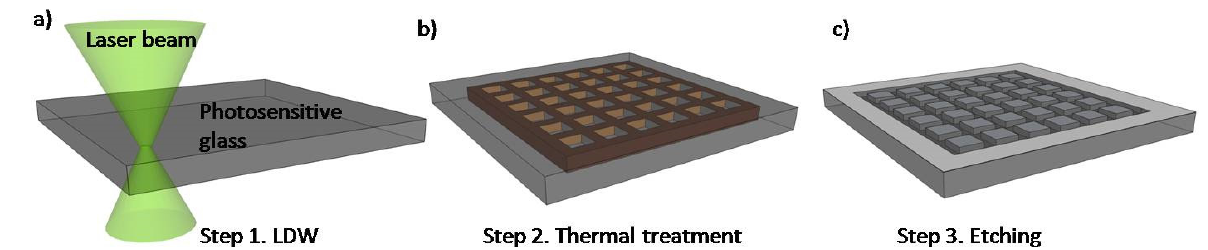
Figure 2. Schematic of photosensitive glass processing based on the technology used in our laboratory: ( a ) picosecond laser direct writing (LDW); ( b ) thermal annealing and ( c ) selective glass etching.